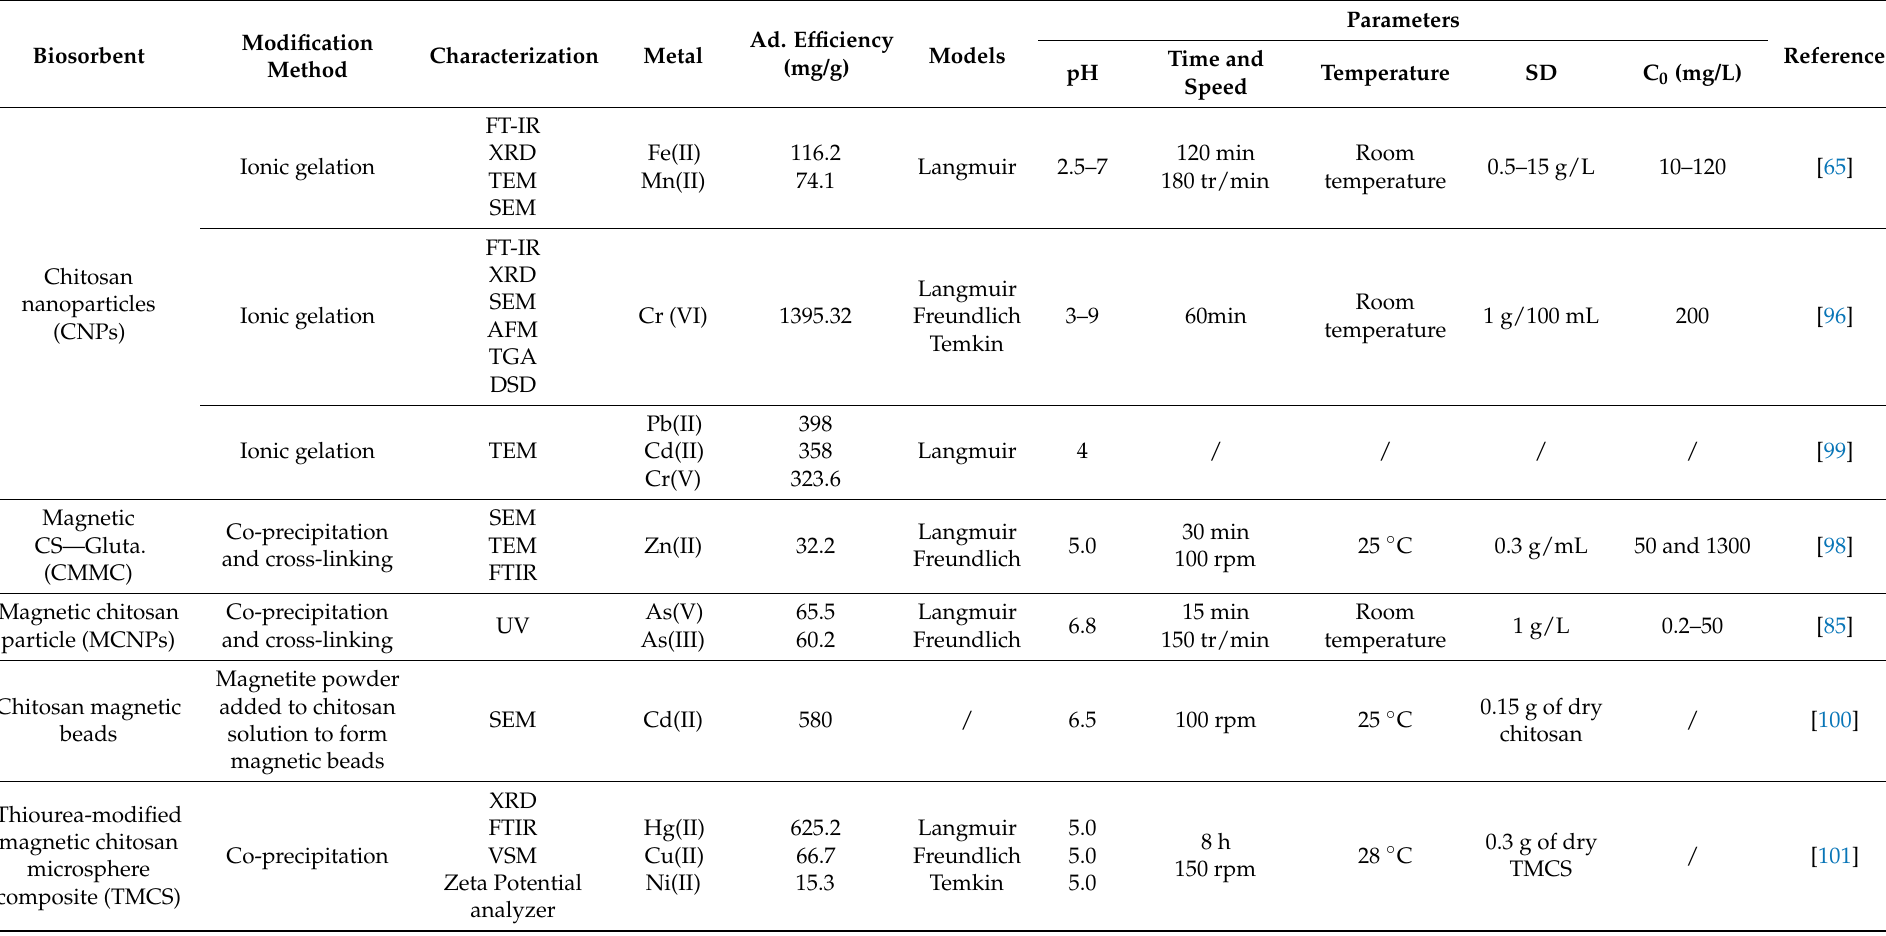
Table 2. Chitosan-based nanomaterials for heavy metal